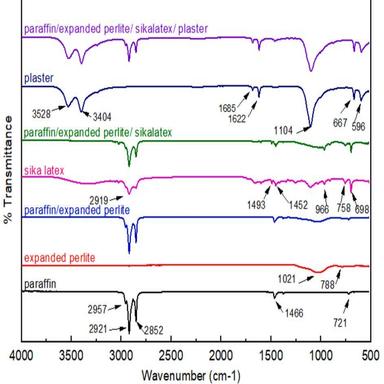
DSC heating and cooling curves of RT27 paraffin and different composites (RT27/EP, RT27/EP/SL, RT27/EP/SL/Al) at 10 k/min.